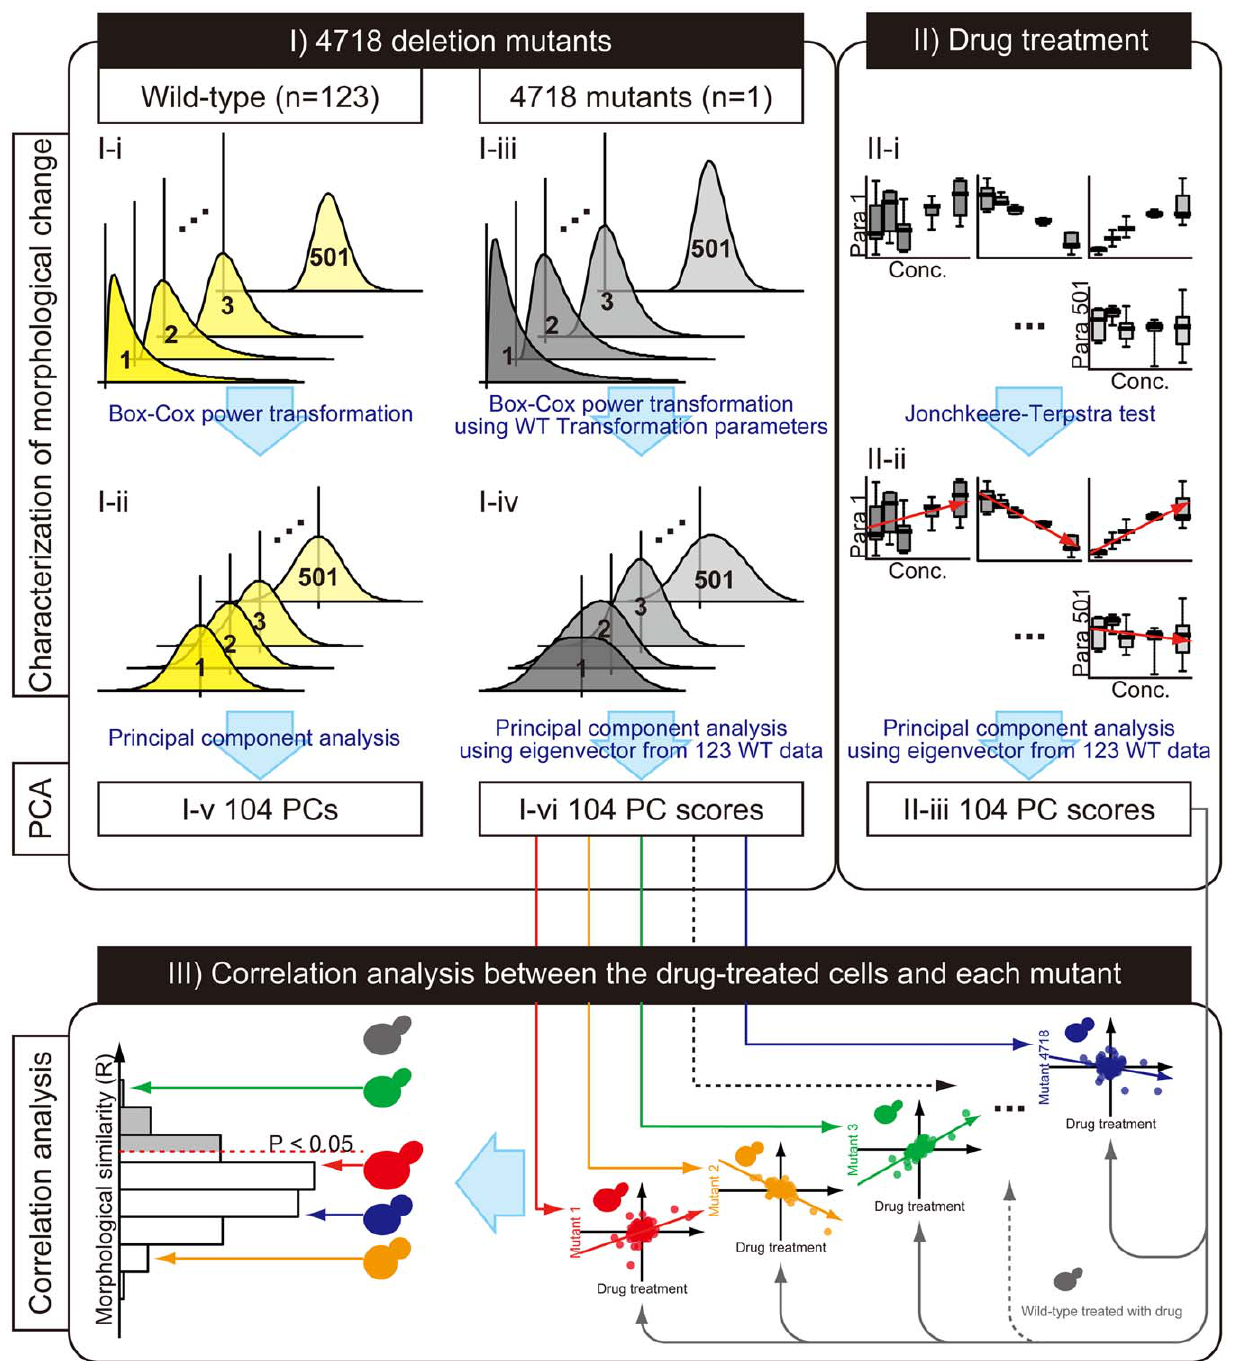
Figure 1. Schematic of the high-content, image-profiling method used in this study. Yellow histograms in I-i and I-ii indicate the original and transformed distributions of 123 wild-type values for each parameter, respectively. Gray histograms in I -iii and I-iv indicate the original and transformed distributions of parameter values for the 4718 mutants, respectively. In I-i, I-ii, I-iii, and I-iv, the vertical and the horizontal histogram axes represent the frequencies and parameter values, respectively. Box plots in II-i and II-ii indicate the distributions of the parameter values from drug- treated wild-type yeast. In the box plots in II-i and II-ii, the vertical and the horizontal axes represent the parameter values and drug concentrations, respectively. Red arrows in II-ii indicate the direction of trends within the parameter data. PC in I-v, I-vi and II-iii indicates the principal components defined by PCA of transformed wild-type data for 501 parameters. The vertical and the horizontal axes in the two-dimensional plots in III indicate the principal component scores for the mutants and drug-treated wild-type cells, respectively. The histogram in III shows the distribution of morphologic similarities between the dose-dependent changes induced drug treatment and those induced by the deletion mutations. Morphologic similarities were defined using the Pearson product-moment correlation coefficient (R); mutants with significantly high positive R values (the gray region in the histogram) were defined as potential targets at two sided P , 0.05 with the Bonferroni correction, which was calculated based on P values from the correlation coefficient test.